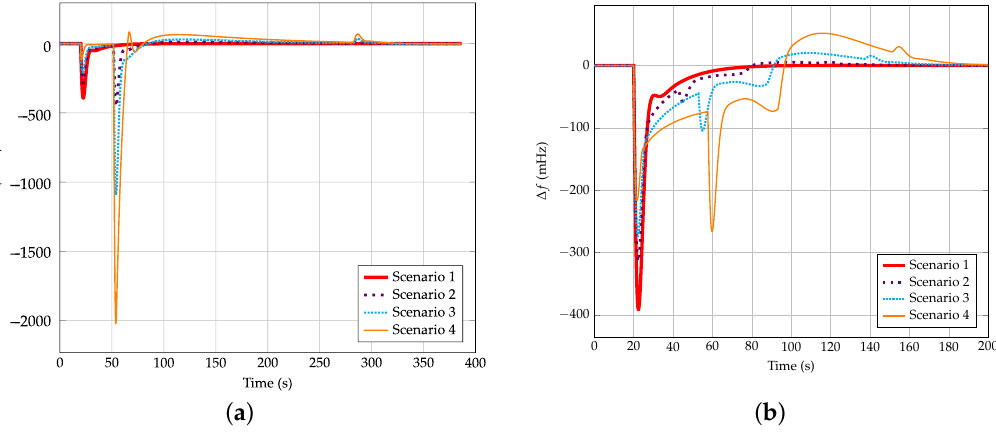
Figure 16. Comparison between frequency excursion for scenarios 1–4 including wind power plant controls and considering ∆ P L = 0.050. ( a ) Controller from [23]; ( b ) Proposed control with x = 0.75.